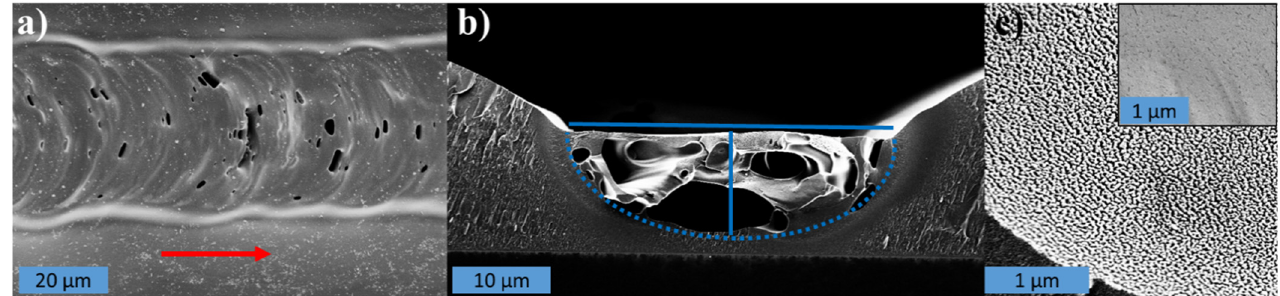
Figure 5. ( a ) Top view SEM image of a laser-written line. The red arrow indicates the writing direction. ( b ) Cross-sectional SEM image of the same line. The dotted blue line outlines the semi-elliptical cross-section of the pyrolyzed (carbonized) part and the solid blue lines indicate the thickness h and width w . ( c ) High-magnification micrograph of the top surface of the line revealing nanostructuring, the inset on ( c ) shows the surface of the non-carbonized SU-8 where no such nanostructuring is seen.